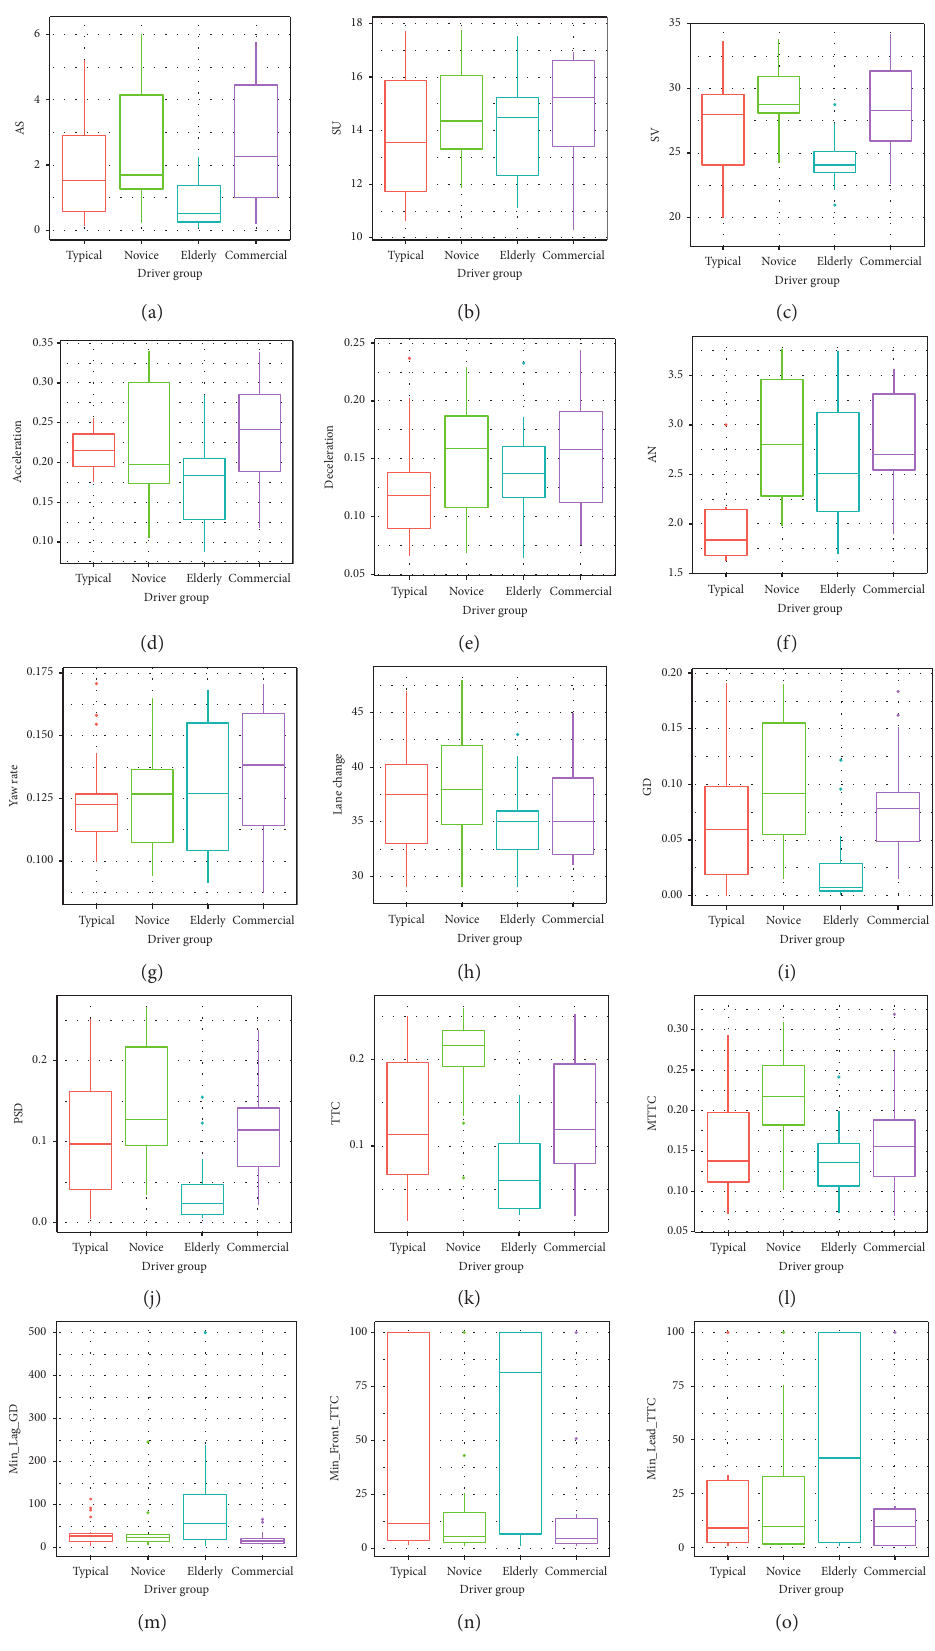
Figure 3: Comparison of surrogate safety measures by driver group: (a) AS (speeding); (b) SU (reckless changing speeds); (c) SV (reckless changing speeds); (d) acceleration (rapid acc. and dec.); (e) deceleration (rapid acc. and dec.); (f) AN (rapid acc. and dec.); (g) yaw rate (erratic steering control); (h) lane change (erratic steering control); (i) GD (tailgating); (j) PSD (tailgating); (k) TTC (tailgating); (l) MTTC (tailgating); (m) Min_Lag_GD (erratic lane-changing); (n) Min_Front_TTC (erratic lane-changing); (o) Min_Lead_TTC (erratic